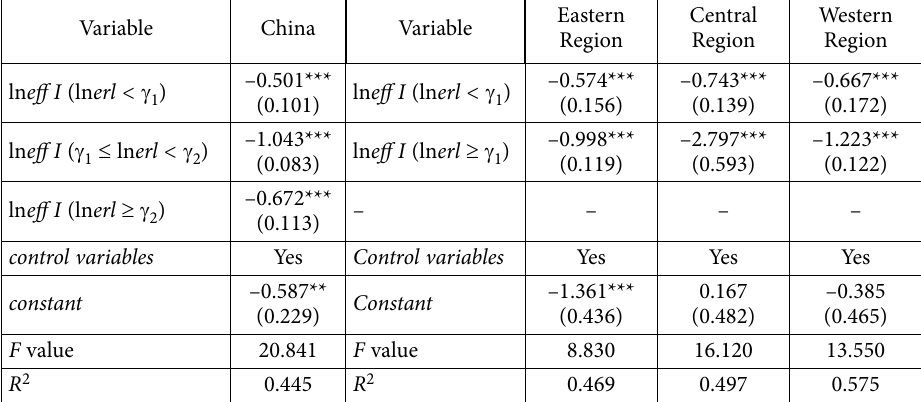
Table 5. Threshold regression results (source: The data in the table are calculated by the software of STATA)